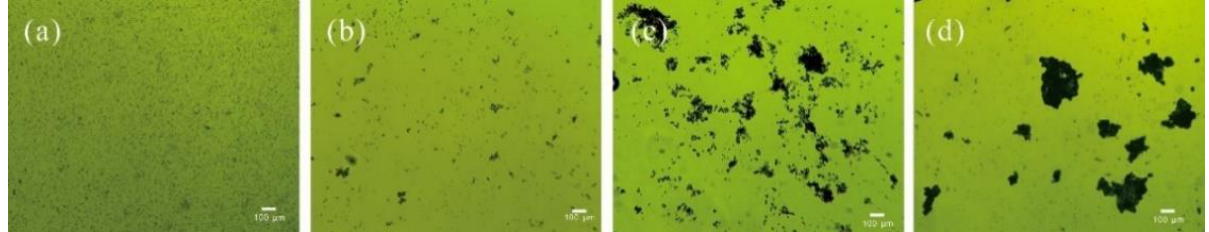
Figure 5. Microscopic images of C. vulgaris ( a ), and C. vulgaris flocs with WPE ( b ), chitosan ( c ), and chitosan and WPE ( d ). To assess the possibility of a chemical interaction between C. vulgaris , chitosan, and WPT during flocculation, FT-IR spectra of all the components were analyzed (Figure 6). Similar to Yuan et al. [57] and Zou et al. [52], C. vulgaris showed a broad absorption band around 3287 cm − 1 , which corresponded to the overlap of the O–H and N–H stretching vibration, and the peak at 2926 cm − 1 attributed to the stretching of O–H and C–H. The sharp peak at 1645 cm − 1 referred to the primary amide group (N–H stretching) and imine group (C=N stretching). The peaks at 1528 cm − 1 , 1391 cm − 1 , and 1340 cm − 1 belong to